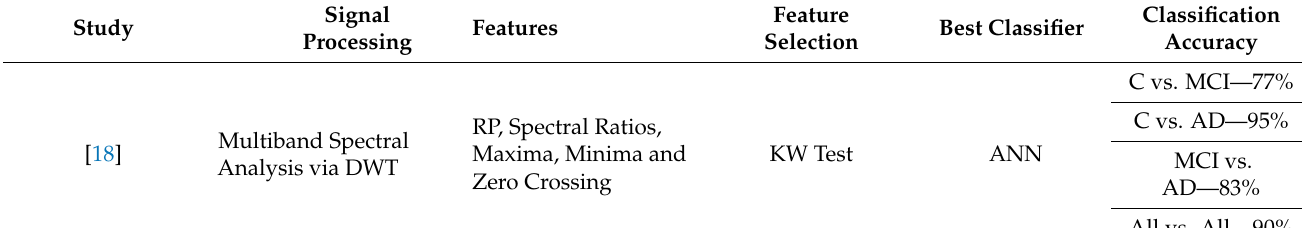
Table 5. Comparison with previous works with the same EEG database.